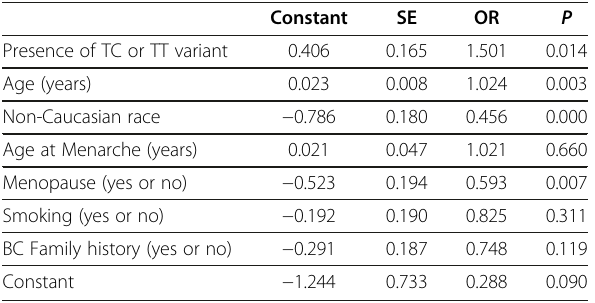
Table 4 Multiple logistic regression analysis adjusted for the interfering variables to evaluate the association between polymorphism and occurrence of